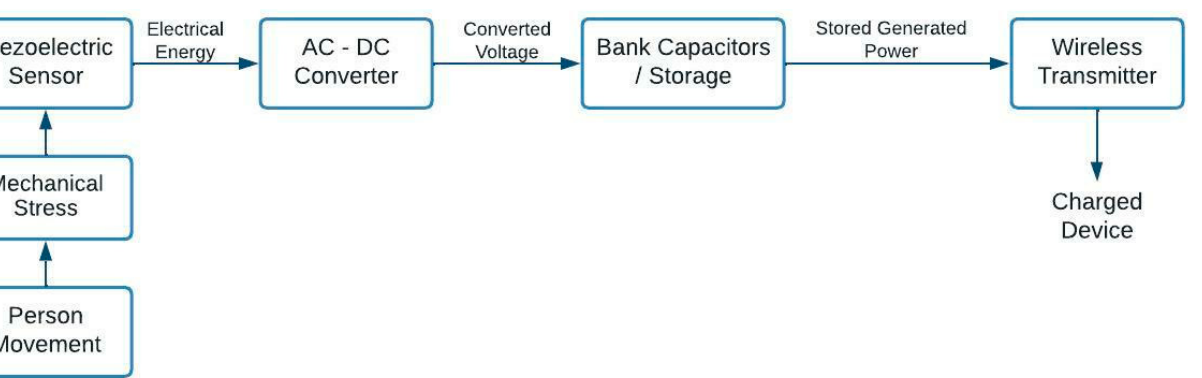
Figure 8. Hardware Components Communication Flowchart.